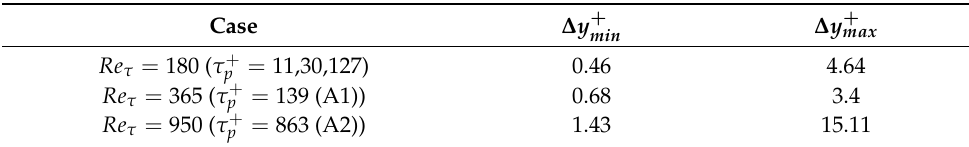
Table 8. Grid resolution/refinement employed for the numerical simulations (normalised in inner wall units).